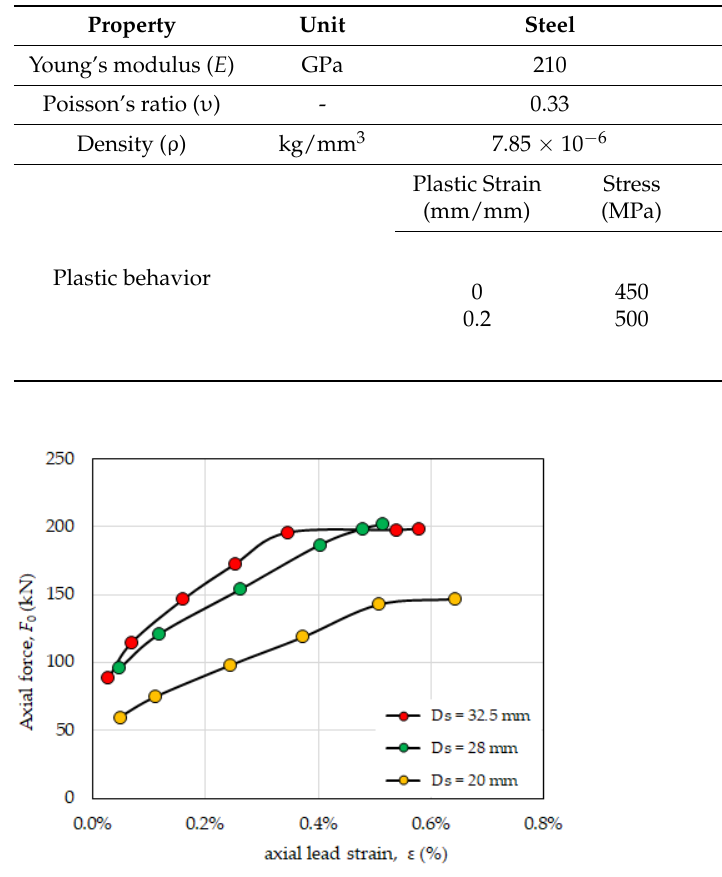
Figure 5. Axial load F 0 of the PS-LED vs. axial strain ε of the prestressed lead core for different diameters of the shaft Ds .